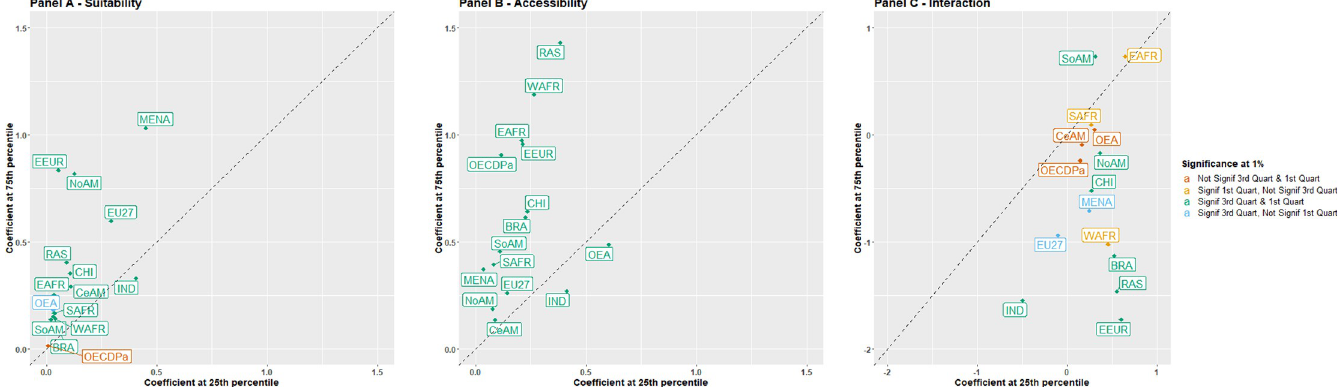
Fig 6. Estimated effects of agricultural suitability (Panel A), market accessibility (Panel B), and the interaction between suitability and accessibility (Panel C) for the first and third quartiles of cropland fractions in 15 regions. Estimates were produced by quantile regression. The first and third quartiles represent the 25% least- and most- cultivated land. Colors indicate the levels of statistical significance for each region. RAS: RestAsia, BRA: Brazil, NoAM: North America, CeAM:Central America, CHI: China, EAFR: Eastern Africa, EEUR:Eastern Europe, IND: India, MENA: Middle East and North Africa, OECDPa: OECD pacific, OEA: Oceania Southeastern Asia, SoAM: South America, SAFR:Southern Africa, EU27: European Union, WAFR: Western Africa.